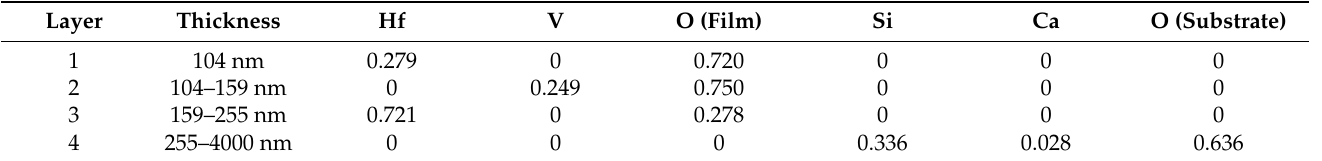
Table 1. In-depth profiling thickness and the elemental ratio of as-deposited